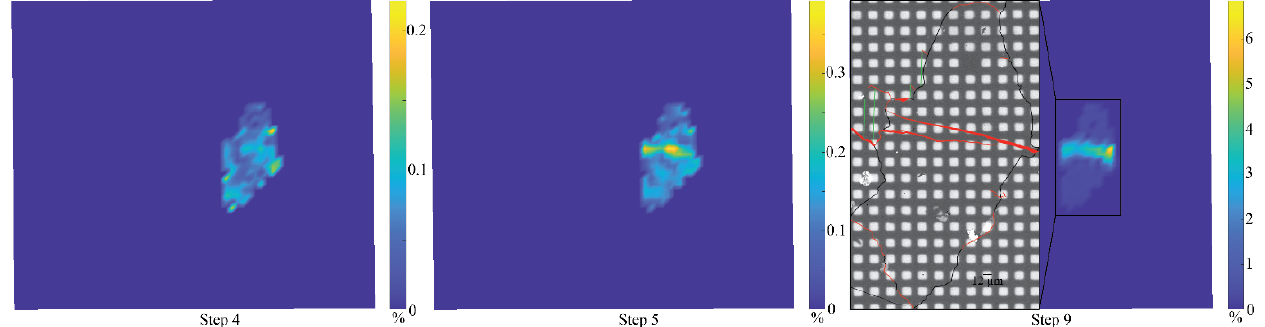
Figure 18. Equivalent Von Mises deformation map of crystal 11 at different steps of sample defor- mation. The black lines represent the grain boundaries. The green lines show the twinned planes. The red lines show the fracture zones.